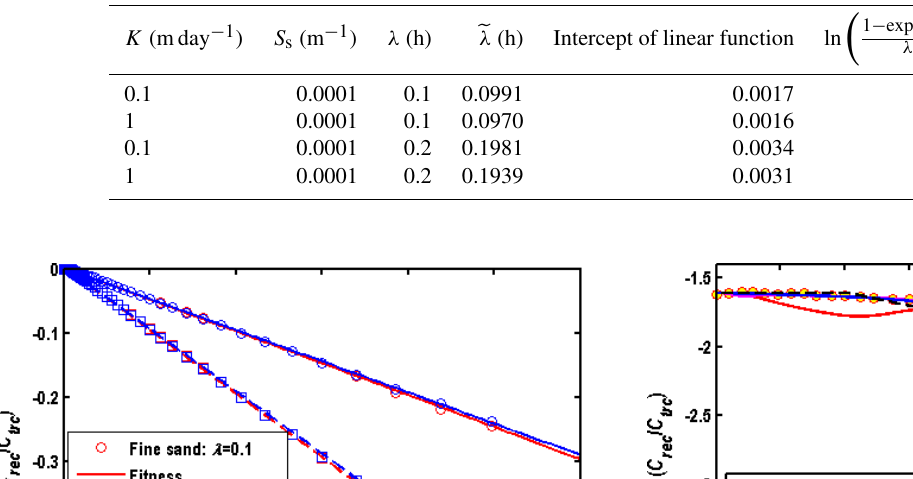
Table 1. Reaction parameters estimated by linear functions.